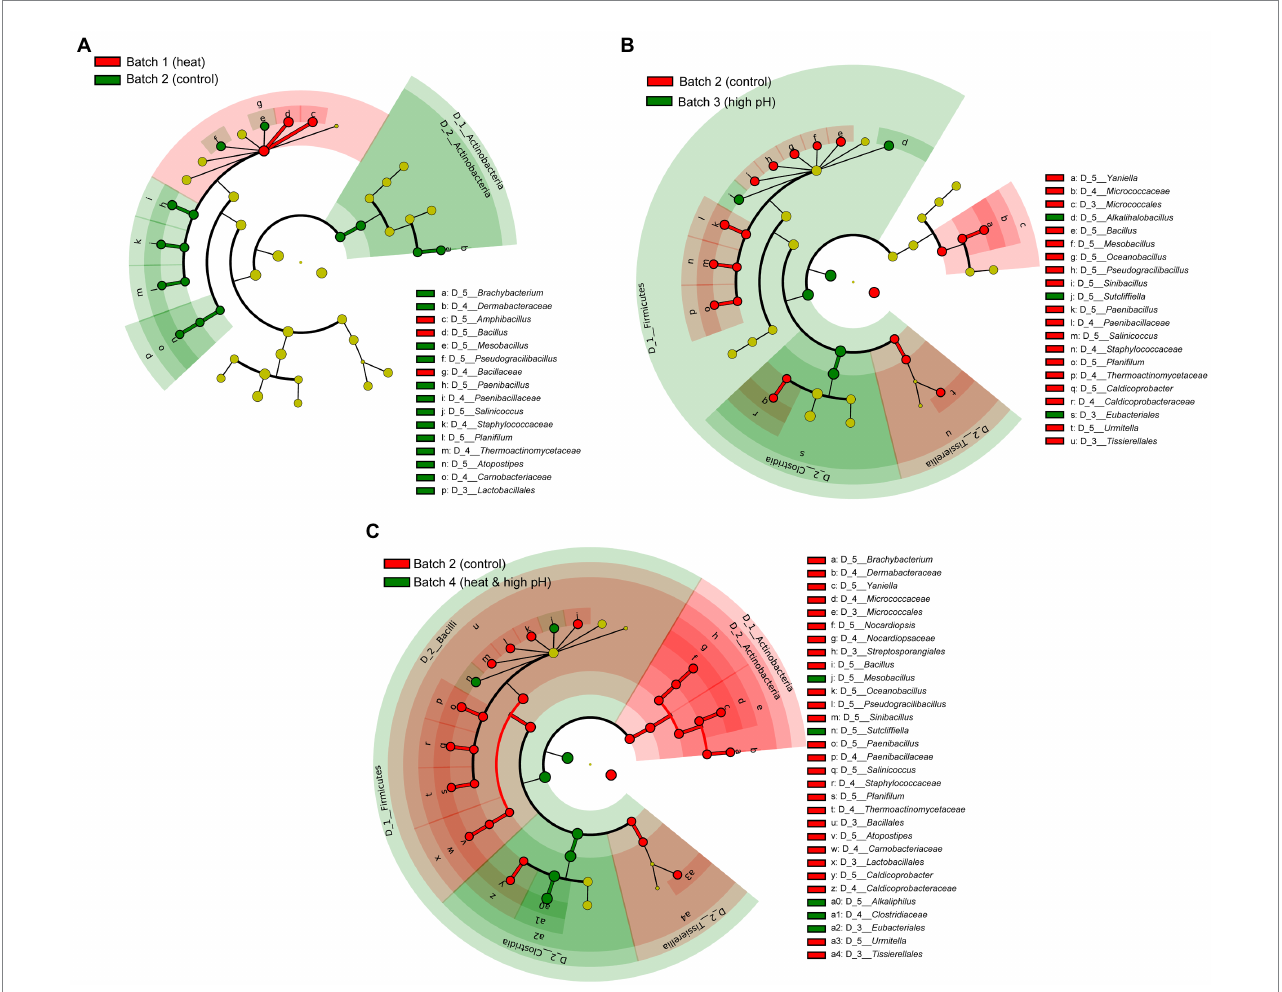
FIGURE 2 Bacterial markers of differently treated sukumo during days 2–5 following different initial treatments. (A) comparison between B1: batch 1 ( sukumo treated with 60 ° C tap water) and B2: batch 2 ( sukumo treated with 25 ° C tap water [control]). (B) comparison between B2 and B3: batch 3 ( sukumo treated with 25 ° C wood ash extract) (C) comparison between B2 and B4: batch 4 (sukumo treated with 60 ° C wood ash extract). The LDA effect size (LEfSe) analysis was performed to identify the markers for each group (significant when LAD score >